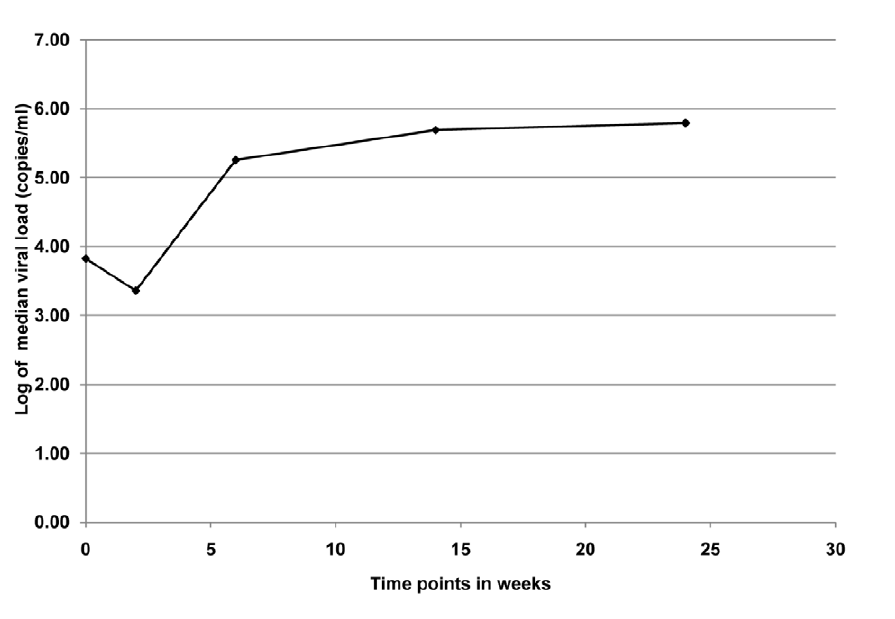
Figure 2. Median viral load for infants ( n =12) who were PCR positive at birth in the KiBS, Kisumu, Kenya, 2003–2008. The trend of median viral load at delivery was 2.8 log copies per ml, decreased , 3-fold at 2 wk, increased , 80-fold from 2 wk to 6 wk, and remained between 5 and 6 log copies per ml through 6 mo.